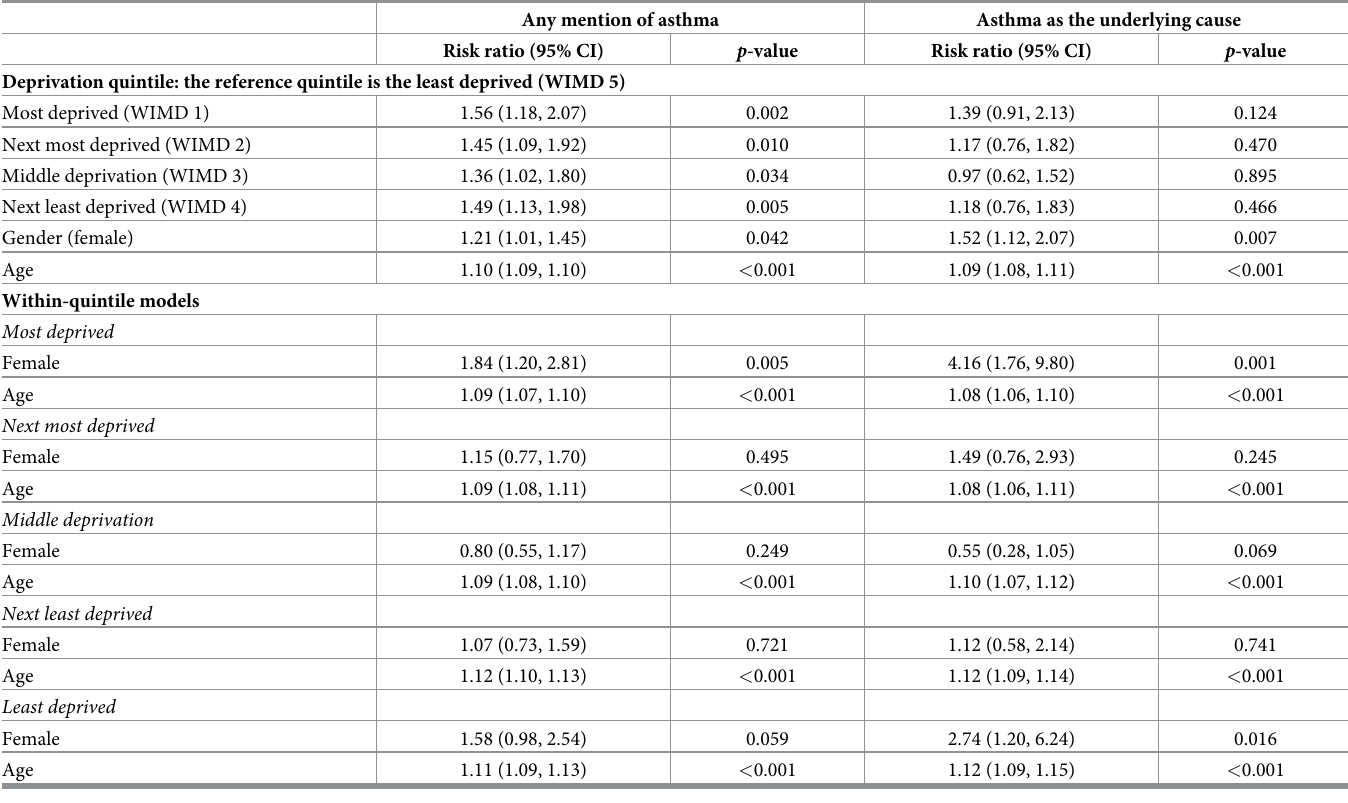
Table 4. Risk ratio of asthma deaths by age and gender within the WIMD 2011 score